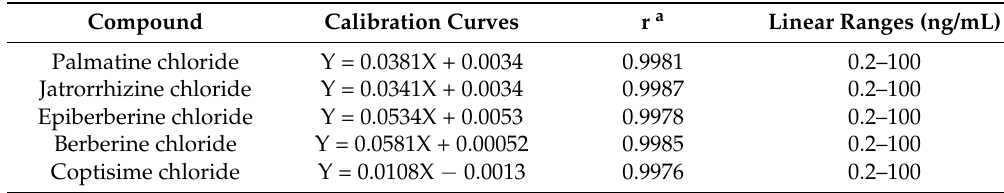
Table 2. Calibration curve parameters for the five alkaloids in plasma ( n = 6). Compound Calibration Curves r a Linear Ranges